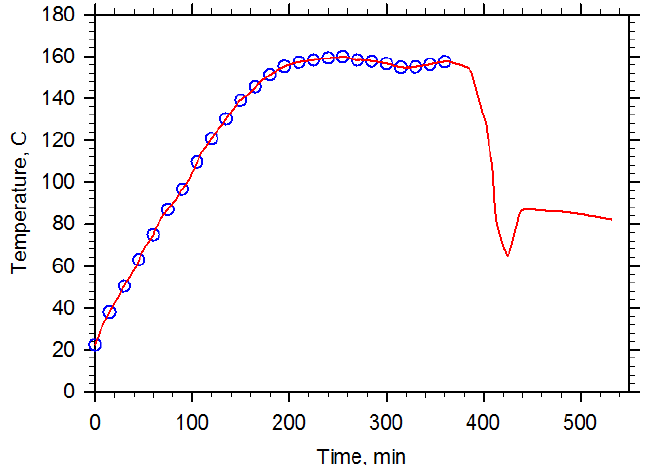
Figure 1. Temperature profile during the hot-water extraction of Northern Boreal Aspen woodchips, with symbols indicating the time at which extraction liquor samples are